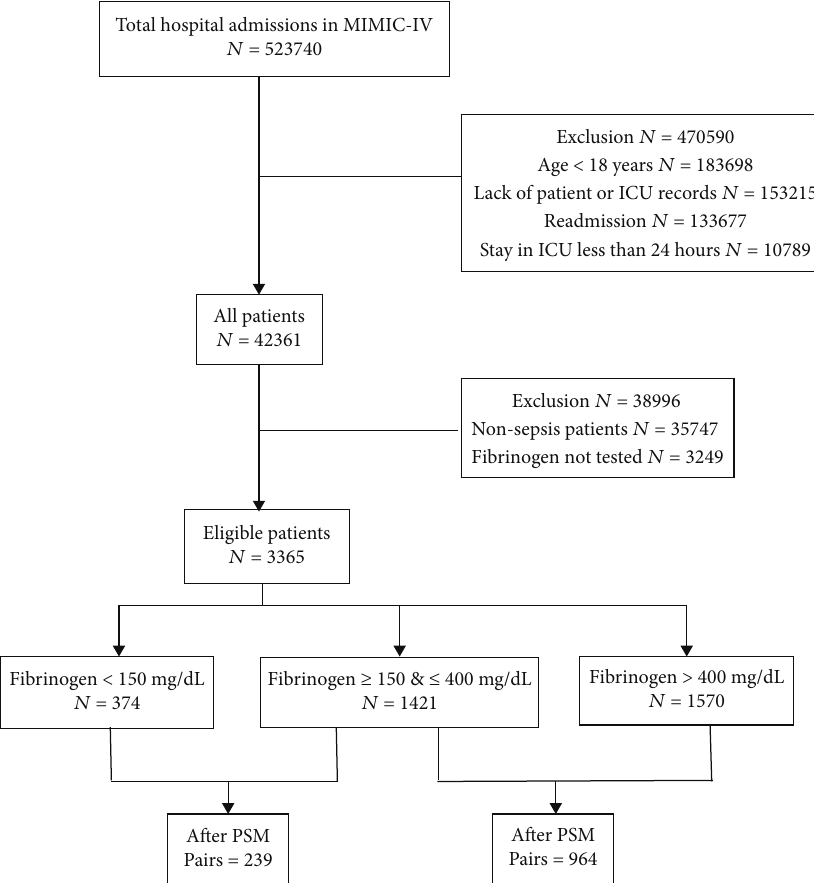
Figure 1: Flowchart of patient